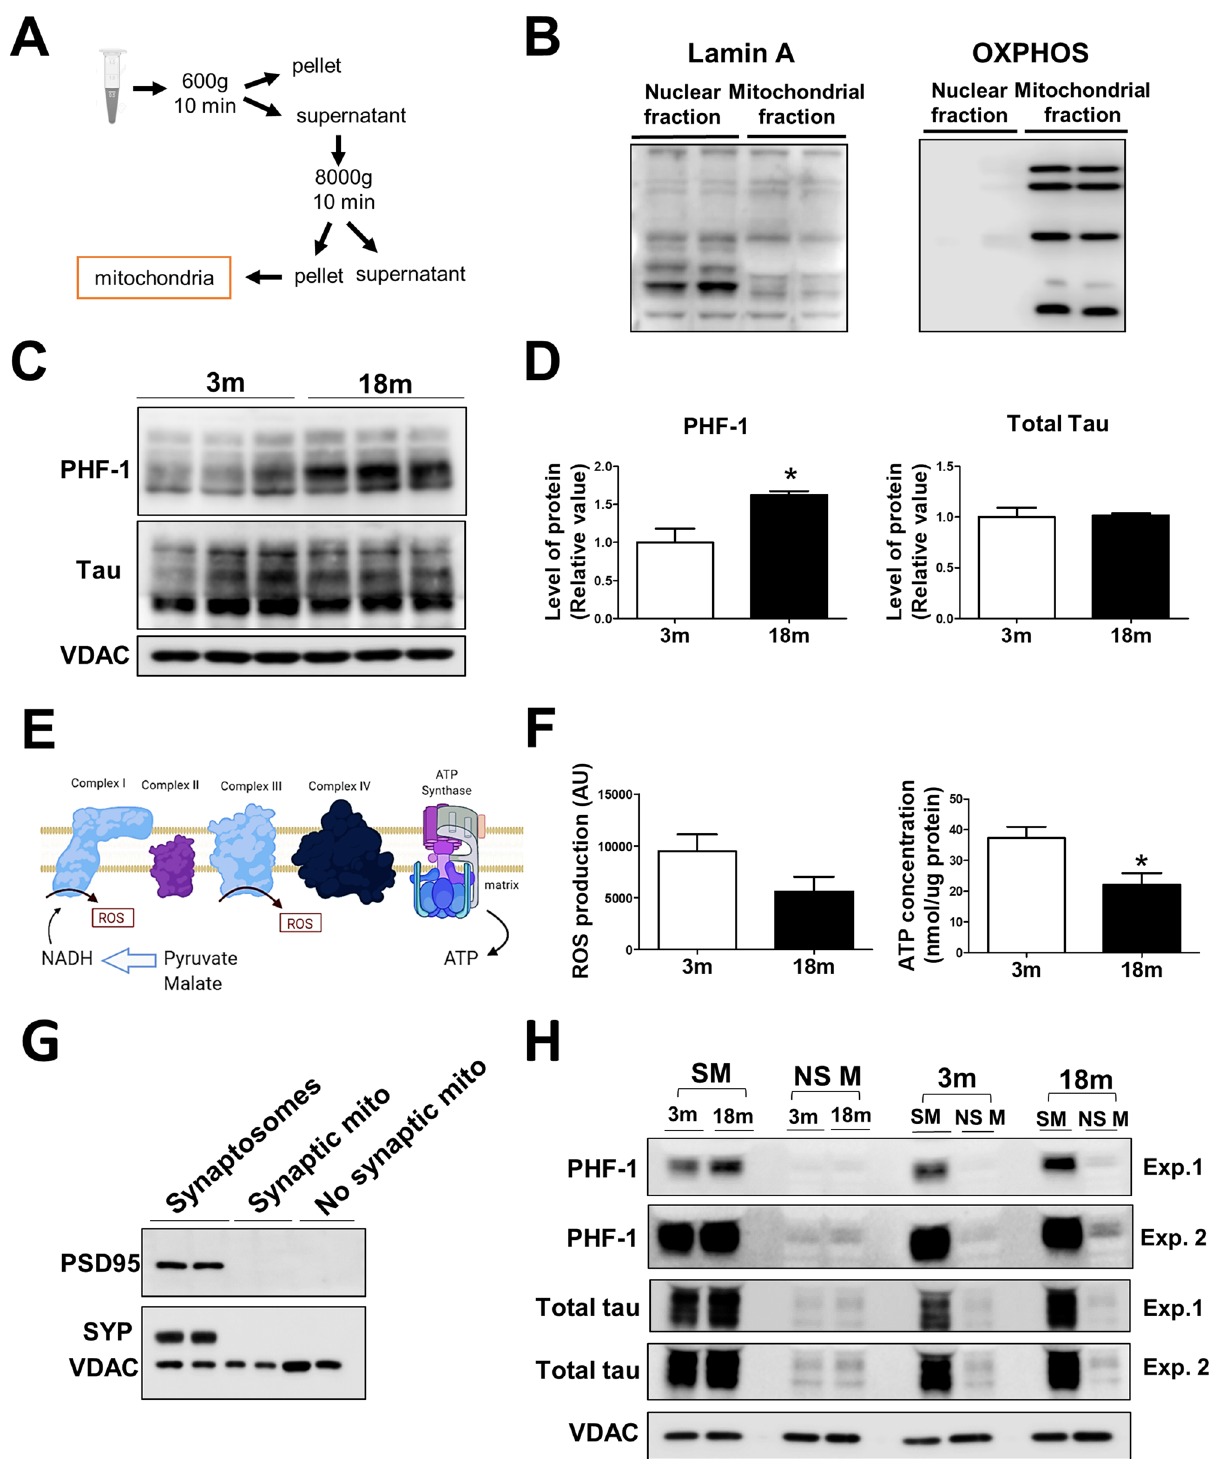
Figure 4. Tau PHF-1 accumulates in hippocampal mitochondria of aged mice. ( a ) Schematic representation of the protocol to obtain a mitochondrial fraction. ( b ) Controls show an enriched mitochondrial fraction. ( c ) Phosphorylated tau at PHF-1 epitope and total tau levels in 3 and 18 month-old (mo) mice were analyzed in a mitochondrial fraction. ( d ) Densitometric analysis of tau PHF-1 and total tau, expressed as a relative value to the control. ( e ) Schematic representation of functional analysis of the mitochondrial fraction using pyruvate and malate as oxidative substrates to stimulate respiration. Created with BioRender.com ( f ). ROS production of isolated mitochondria measured by the fluorescent dye CM-H2DCFDA (to indirectly evaluate the mitochondrial activity of complexes I and III) and ATP production measured by luminescence, both after exposure to oxidative substrates. ( g ) Synaptic and non-synaptic mitochondria were isolated from the hippocampus of 3 and 18 mo mice to measure phosphorylated tau (PHF-1) in both mitochondrial populations. ( h ). Levels of tau PHF-1 and total tau in both synaptic and non-synaptic mitochondria, using VDAC as a loading control. Two different exposure types are showed to demonstrate the reduced levels of both phosphorylated and total tau in the non-synaptic mitochondrial population. n = 3 different animals. Graph bars represent means ± SEM. * p <